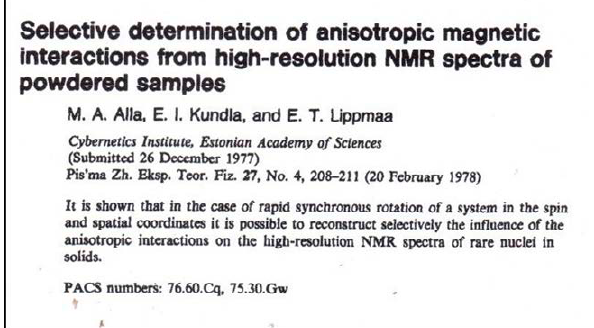
Figure 3. A photocopy of the abstract of the article in the Letters of JETP [31] devoted to the determination of the anisotropic chemical shift 13 C in the NMR spectrum of